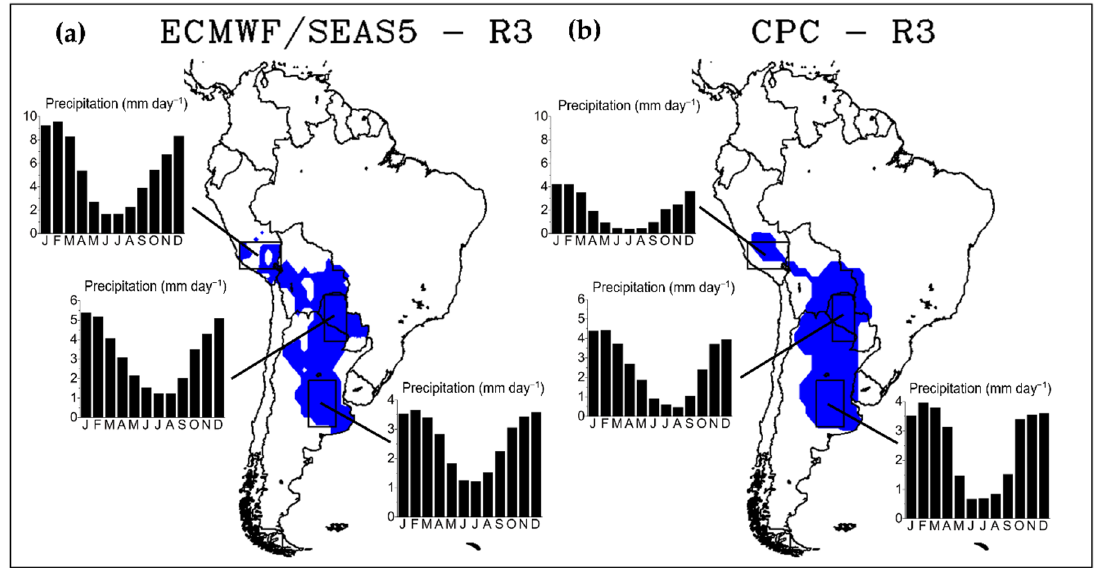
Figure 8. Similar to Figure 6, except for Region 3